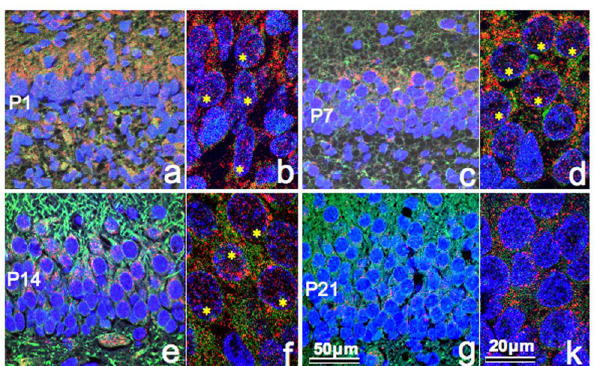
Figure 5. Fluorescent immunoreactivity of prosaposin (PS), microtubule-associated protein (Map-II) and 4 9 ,6-diamidino-2- phenylindole (DAPI). Fluorescent micrographs of the upper blade of the dentate gyrus show immunoreactivity of PS (red), Map-II (green) and DAPI (blue) at postnatal day (P)1 ( a , b ), P7 ( c, d ), P14 ( e, f ) and P21 ( g, k ). Note that a number of nuclei (asterisks) at P1, P7 and P14 contain PS immunoreactivity, but those at P21 contain only background levels of immunoreactivity ( k ). TTCATTACCCTAGACCCACAAGTAGGC- GACTTCTGC-3 9 N S1: 5 9 - GCAGAAGTCGCCTACTTGTGGGTCTAGGG- TAATGAA-3 9 N AS3: 5 9 -CTTGGGTTGCTGATCCTGCATGTGCATCAT- CATCTG-3 9 N AS4: 5 9 -TTCCTTGGGTTGCATGTGCATCATCATCTG- GACGGC-3 9